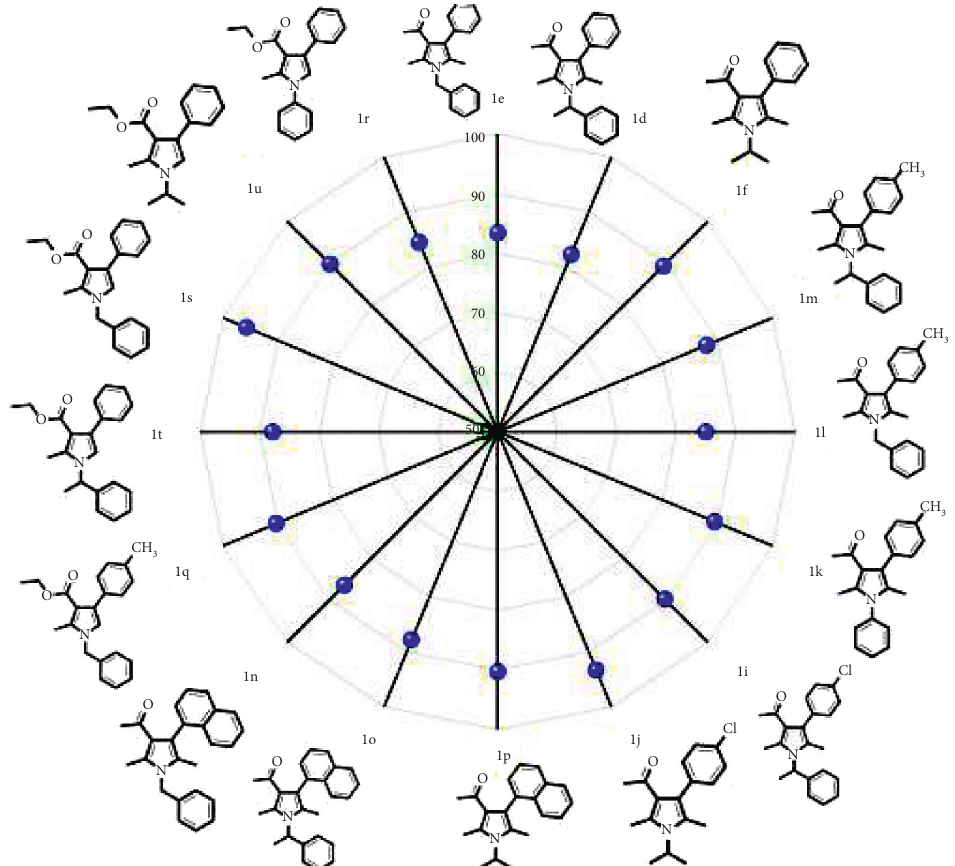
Figure 2: Distribution of inhibition efficiency of different